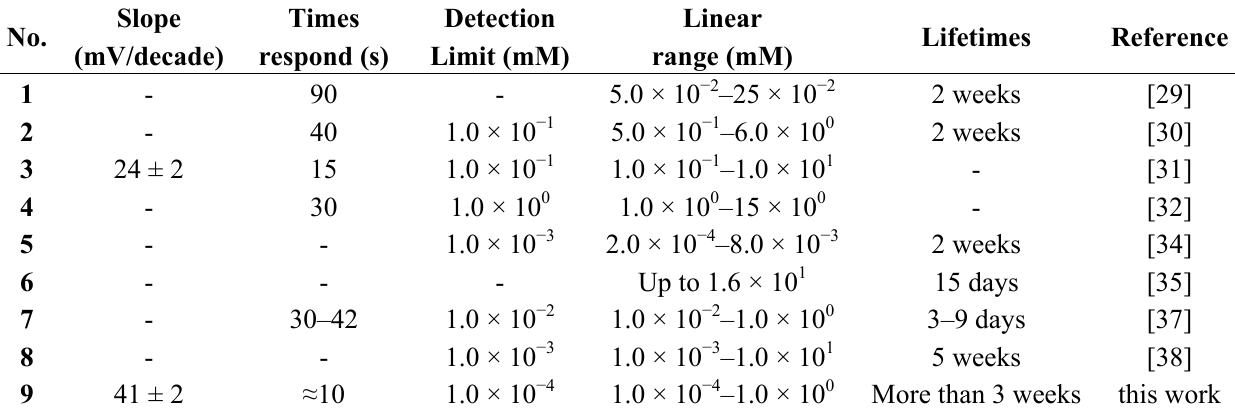
Table 3. Comparison of lactose biosensor with the previous